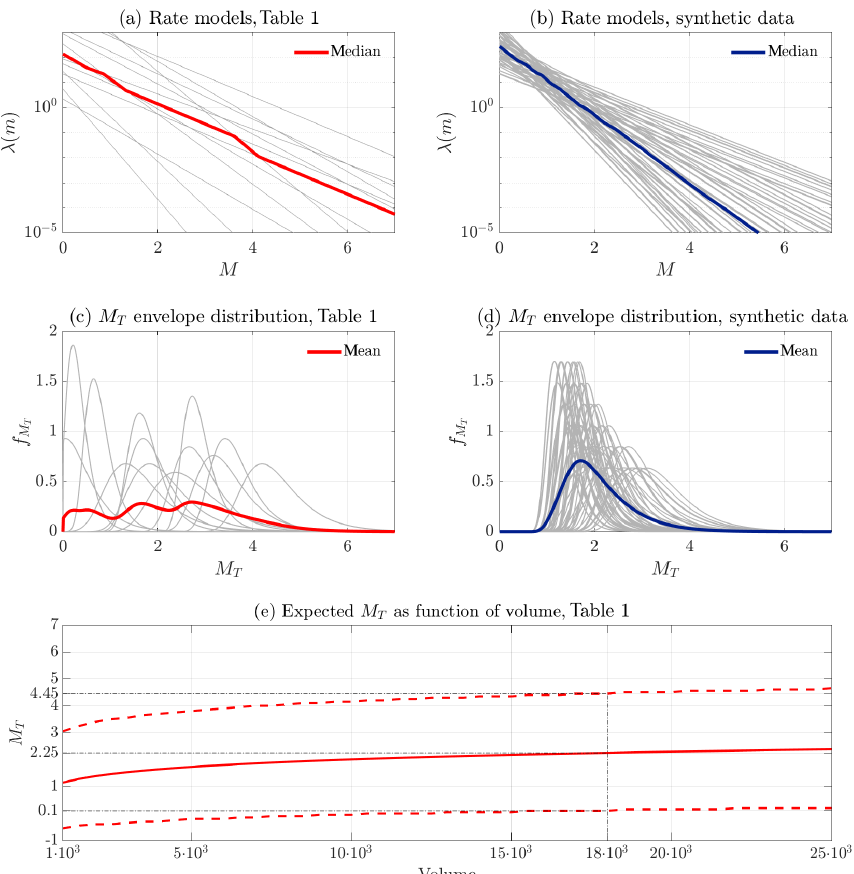
Figure 6. Envelope probabilistic density distribution of the rate model and maximum observed magnitude M max (a, c) based on Table 1 and (b, d) based on synthetic catalog (S2 source model). (e) Expected magnitude per volume injected based on Table